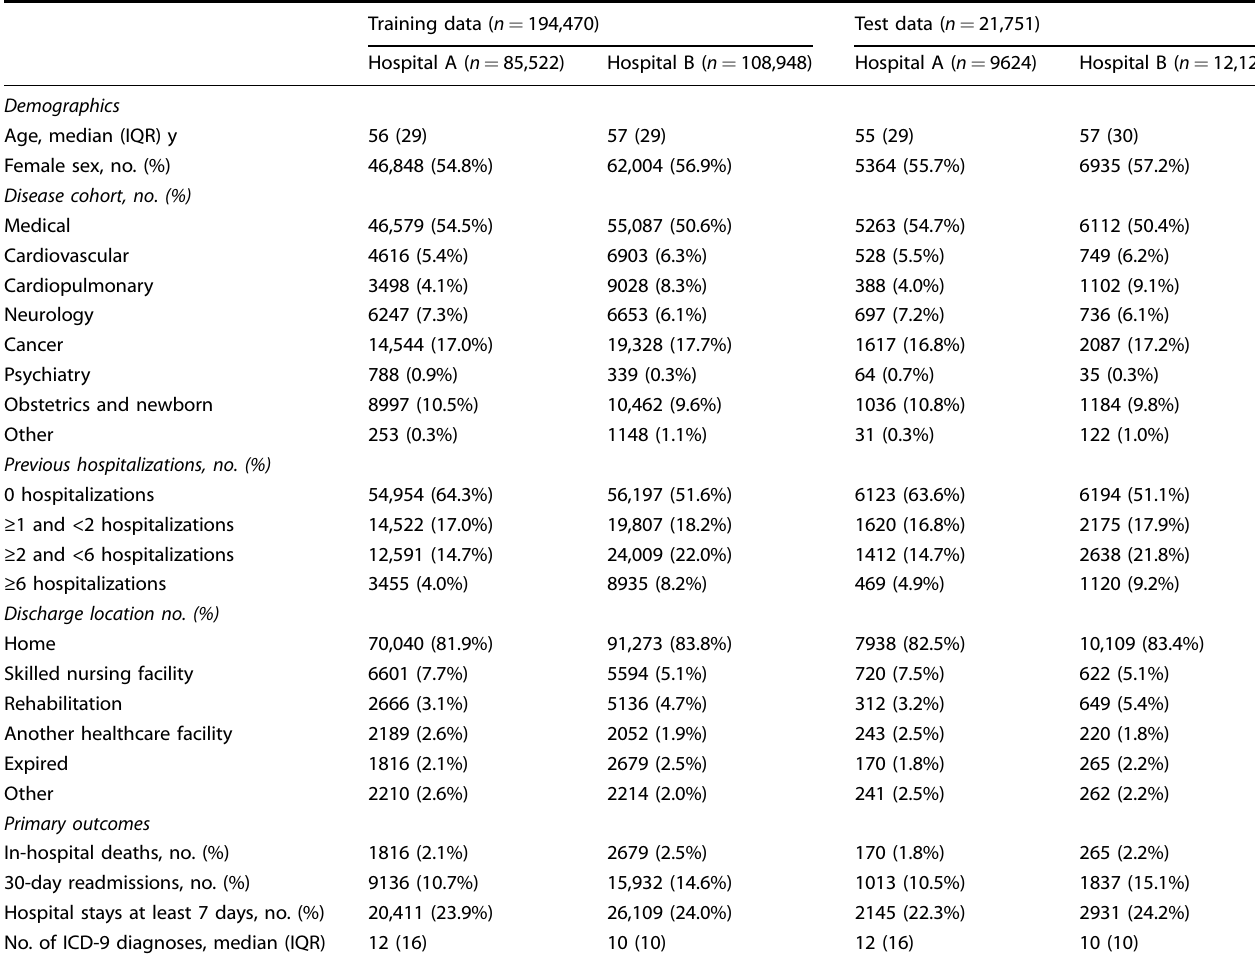
Table 1. Characteristics of hospitalizations in training and test